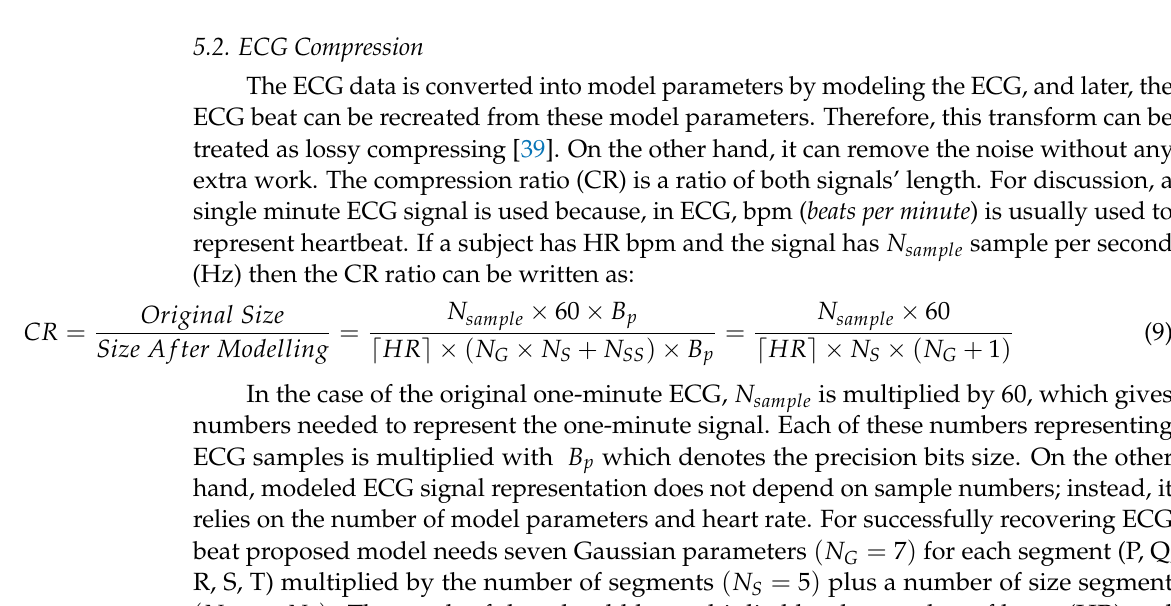
Figure 12. ECG simulation by model for 10 s. For bradycardia with BPM (beat per minute) 50, sinus rhythm with BPM 72, tachycardia with BPM 120.